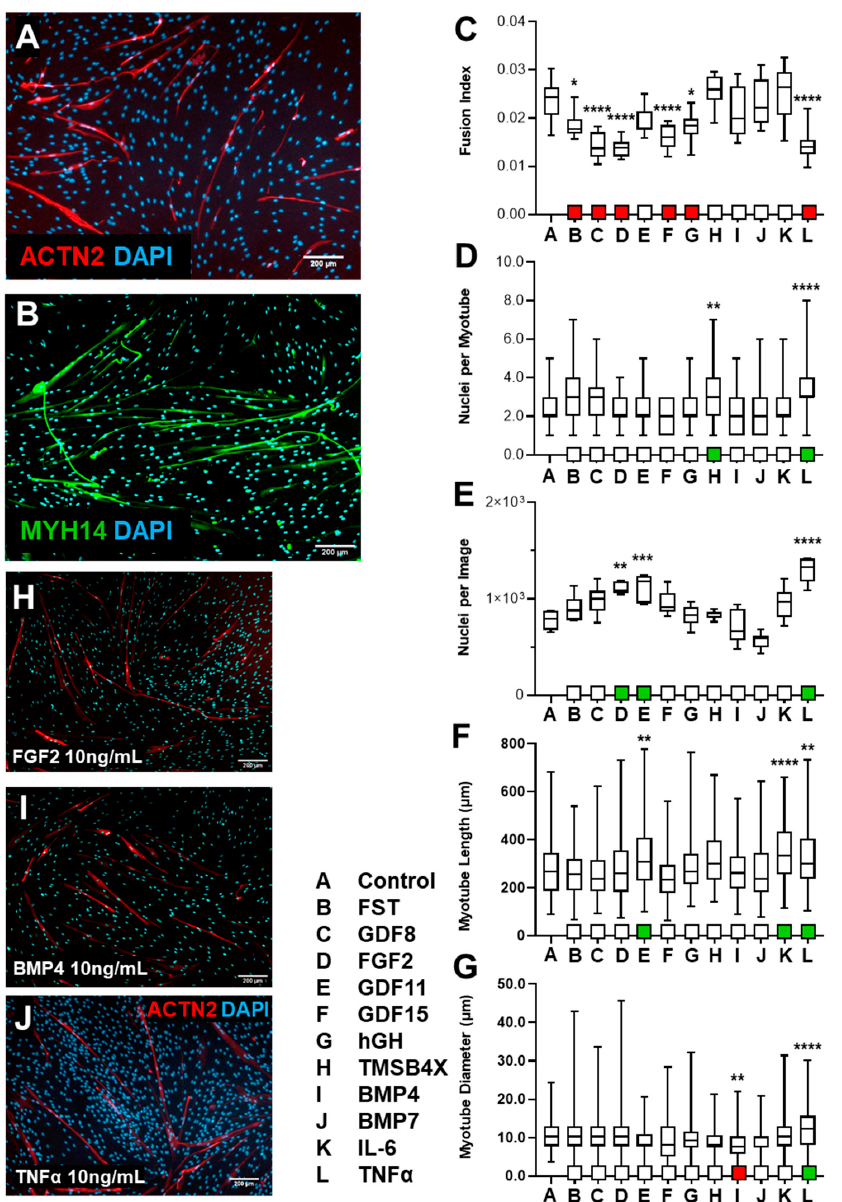
Figure 2. Assessment of differentiation of Human Skeletal Myoblasts (HSkM) with treatment of biological ligand. HSkM were initially differentiated for a period of 7 days before the exposure of biological ligands (10 ng/mL), for an additional 7-day period, and subsequently immunostained with ACTN2 or MF20, to determine impact on myotube differentiation. ( A ) ACTN 5 × microscopy of untreated HSkM. ( B ) Cells staining with MF20 displayed elongated, multinucleated skeletal muscle cells. ( C ) Fusion index of HSkM cells was calculated by evaluating myotube nuclear density ratio with total nuclear count ( n = 12, mean + SD). ( D ) Multinucleation levels, as single myotube nuclear count, were quantified ( n > 45, mean + SD). ( E ) Overall nuclear count was calculated by recording the total number of nuclei per field, 5 × microscopy ( n = 6, mean + SD). ( F ) Differentiated HSkM length ( µ m) were derived from ACTN2+ cells ( n > 120, mean + SD). ( G ) Myotube diameter ( µ m) was also measured ( n > 150, mean + SD). ( H ) Immunofluorescence imaging of FGF2 treated cells showed increased nuclear density, although fusion index decreased. ( I ) No significant change in skeletal muscle differentiation appeared from exposure to BMP4. ( J ) TNF- α screening displayed improved multinucleation, increased nuclear count, increase in length and diameter with reduced fusion index. * p < 0.05, ** p < 0.01, *** p < 0.001, **** p <